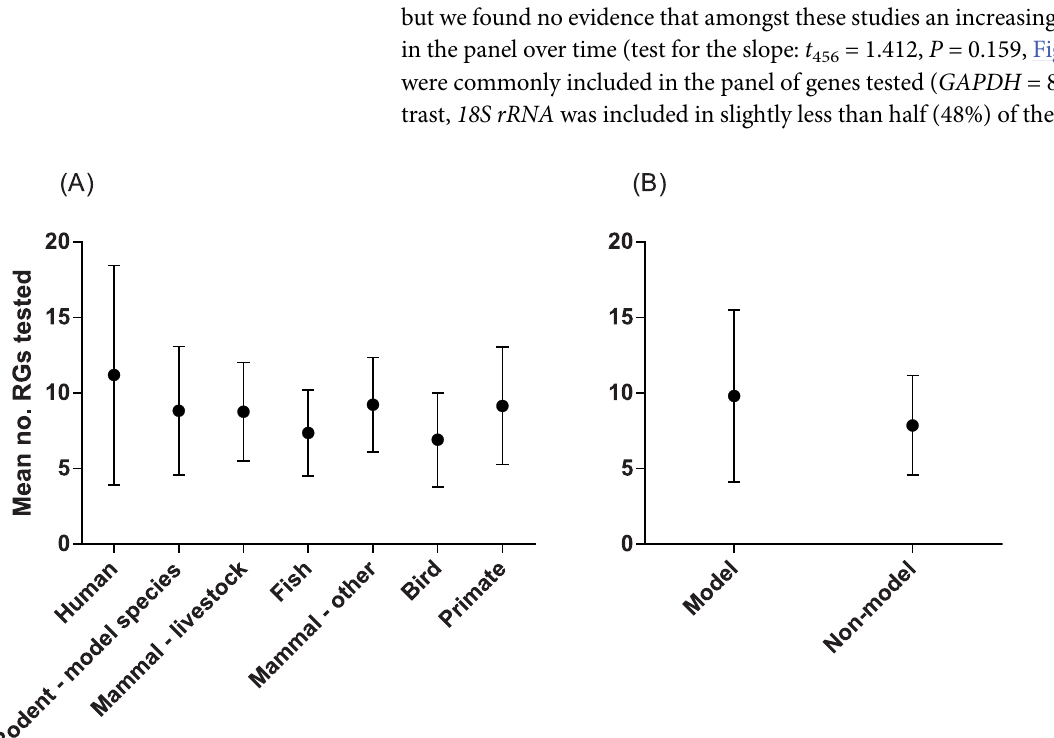
Fig 6. Number of RGs tested for stability based on taxonomic categorisation of study organism. (A) Number of RGs used per species grouping. (B) Number of RGs used in model and non-model species. In both cases, data is represented as mean (dot) ± standard deviation (bars).